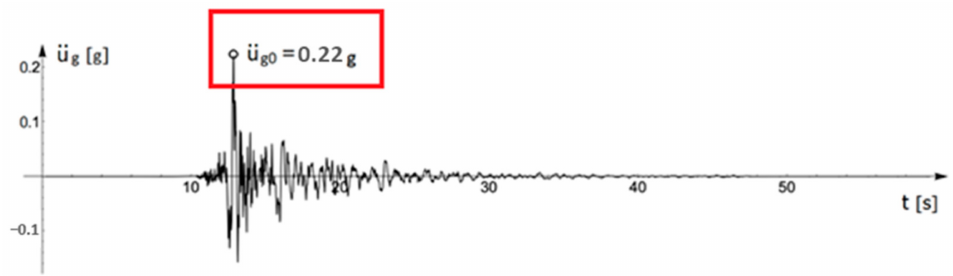
Figure 1. The recording of the peak ground acceleration (PGA) for the Zagreb earthquake in the dominant North–South direction [2].